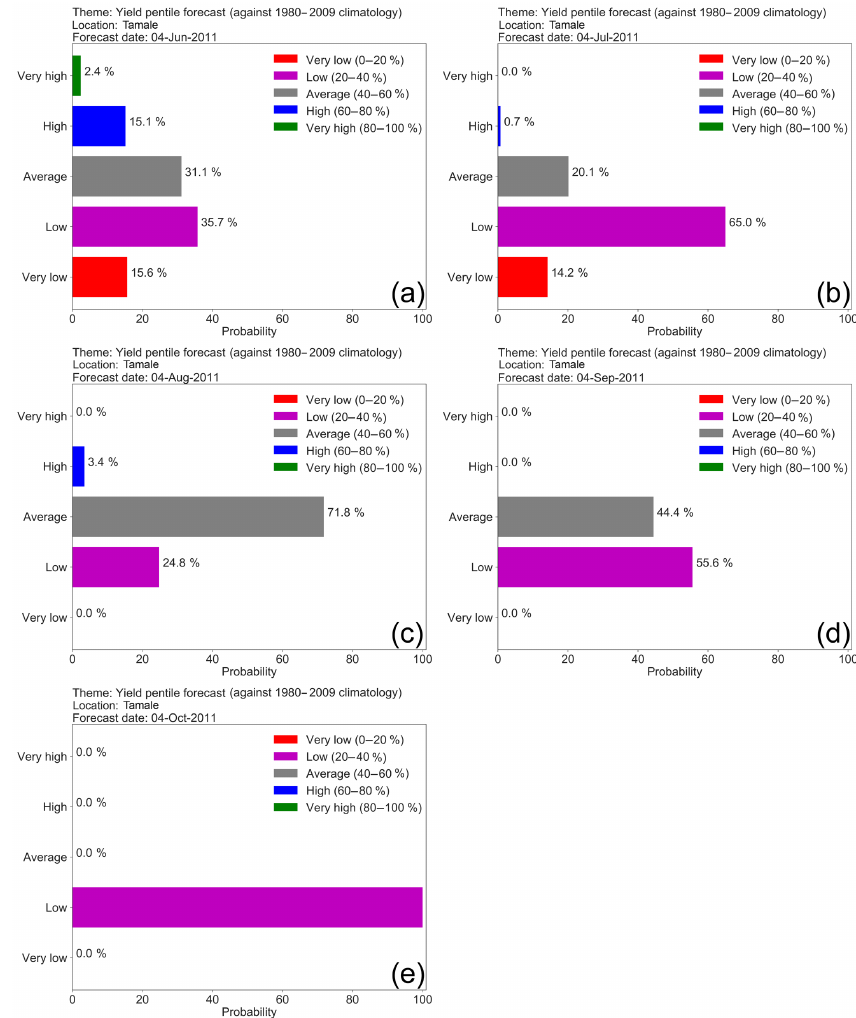
Figure 13. Yield probability forecast for the year 2011 for five forecast dates, (a) 4 June, (b) 4 July, (c) 4 August, (d) 4 September and (e) 4 October, when ensembles are weighted by a perfect average temperature of seasonal